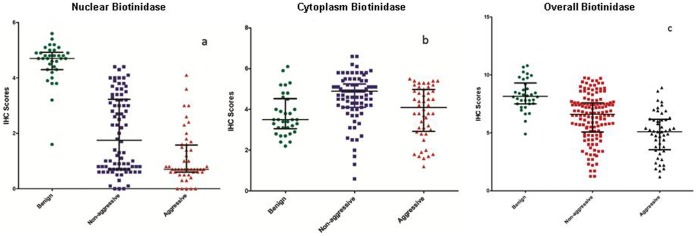
Scatter plot analysis of biotinidase nuclear, cytoplasmic and overall expression.Scatter plots showing distribution of total immunostaining scores determined by IHC of tissue sections of benign (n = 34), non-aggressive (n = 81) and aggressive (n = 48) thyroid cancer tissues. The vertical axis gives the total immunohistochemical score as described in the Methods. a) Decreased nuclear accumulation of biotinidase was observed in aggressive and non-aggressive thyroid cancers analyzed. Scatter plot shows the reduction in nuclear biotinidase immunostaining with increasing tumor aggressiveness; b) Increased cytoplasmic accumulation of biotinidase was observed in the thyroid cancer analyzed with reduction in expression in aggressive compared to non-aggressive PTC; c) Scatter plot showed reduced overall biotinidase immunostaining with increasing tumor aggressiveness.